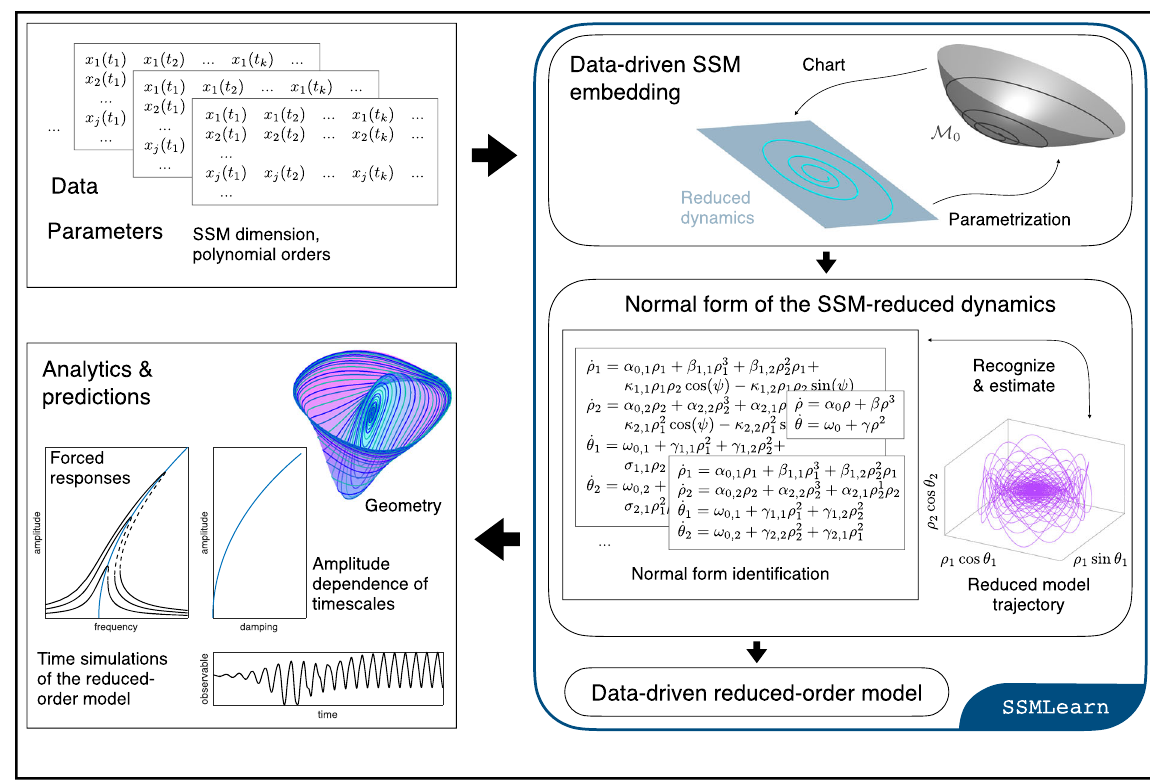
Fig. 3 Schematics of SSMLearn. First, he data-driven, SSM-based model reduction algorithm implemented in SSMLearn diagnoses and approximates the dominant SSM from the input data. Next, it constructs a data-driven reduced-order model as an extended normal form on the SSM. Finally, the algorithm uses this model to predict individual unforced trajectories and the response of the system under additional